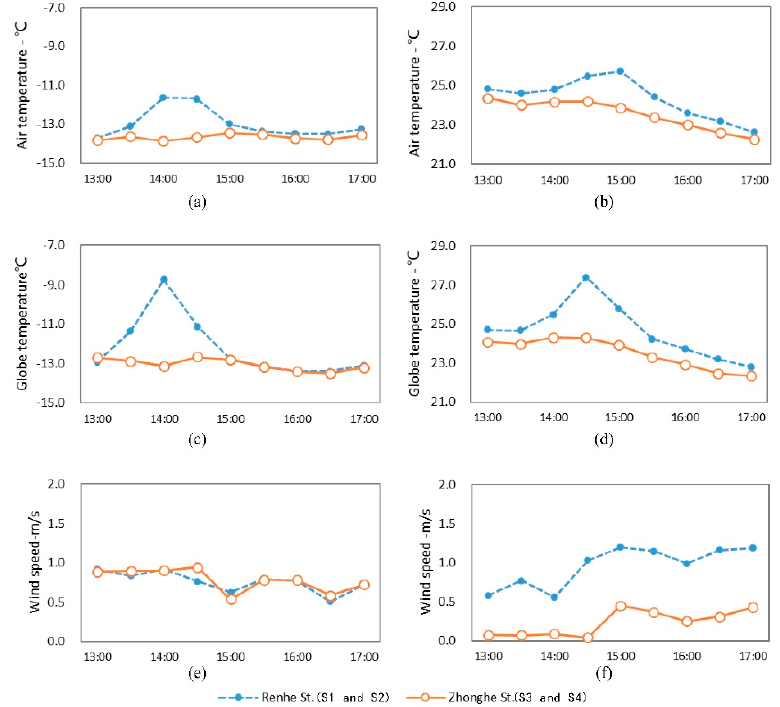
Figure 5. Variation in microclimate parameters of streets with di ff erent green coverage ratios. ( a ) T a in winter; ( b ) T a in summer; ( c ) T g in winter; ( d ) T g in summer; ( e ) wind speed in winter; ( f ) wind speed in summer.